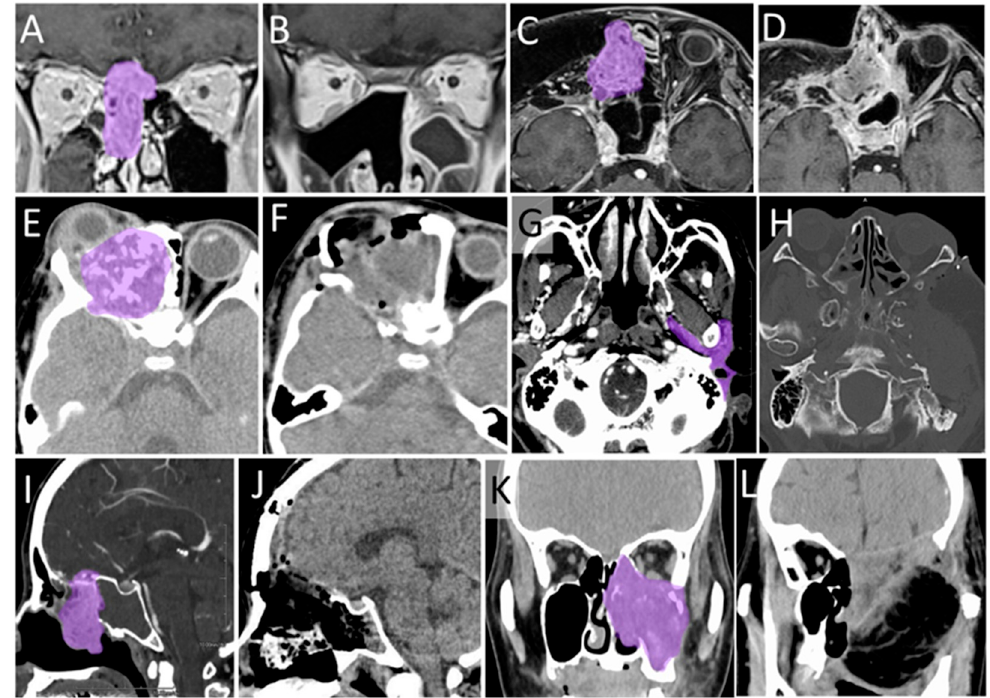
Figure 9. Pre- and postoperative images of Cases 3–8. ( A , B ) Gadolinium-enhanced T1 weighted coronal MRI images of Case 3, ( C , D ) Gadolinium-enhanced T1 weighted MRI images of Case 4, ( E , F ) CT images of Case 5, ( G , H ) CT images of Case 6, ( I , J ) Sagittal CT images of Case 7, ( K , L ) Coronal CT images of Case 8. ( A , C , E , G , I , K ) Preoperative images, ( B , D , F , H , J , L ) postoperative images. Purple; tumor. MRI, magnetic resonance imaging; CT, computed tomography.